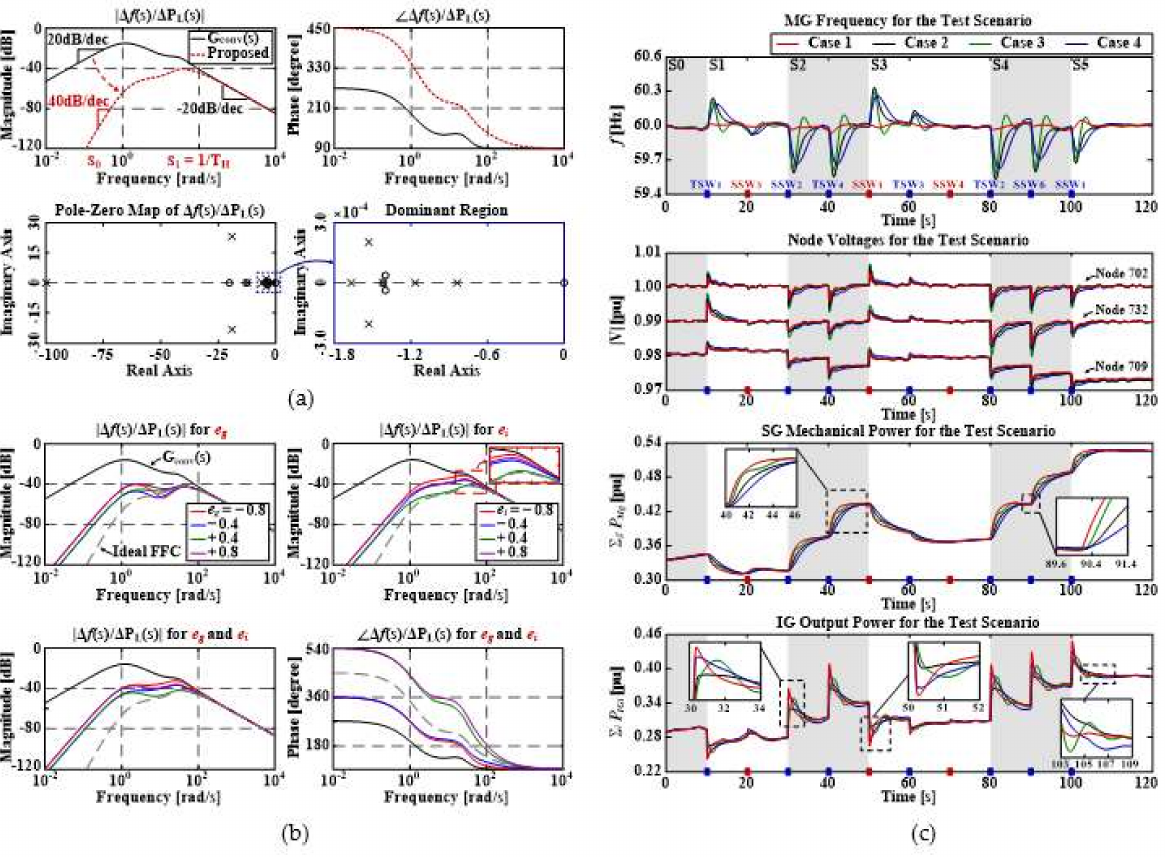
Figure 11. ( a ) Bode plots of the ∆ f ( s )/ ∆ P L ( s ) values for the new FR strategy (Case 1) and conventional FR strategies (Cases 2–4); ( b ) Bode plots of ∆ f ( s )/ ∆ P L ( s ) values with the errors in DG parameter estimates; and ( c ) comparisons of f , | V |, Σ g P Mg , and Σ i P IGi (from top to bottom) during NR-aided load